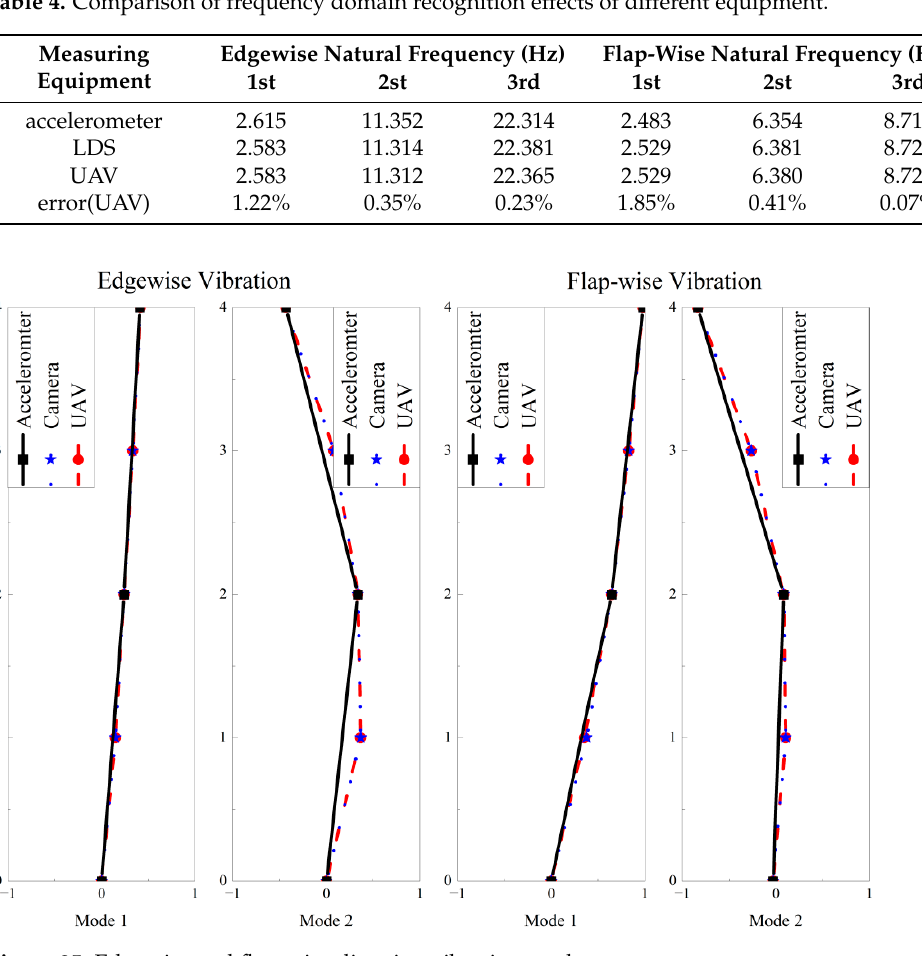
Figure 25. E dgewise and flap-wise direction vibration